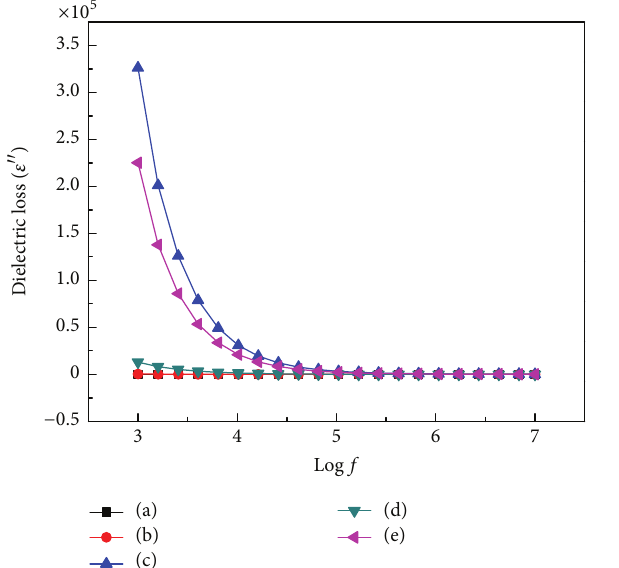
Figure 8: Electric modulus of real part versus frequency for various Ppy/TiO 2 composites (a) 1wt% Ppy/TiO 2 , (b) 2 wt% Ppy/TiO 2 , (c) 3 wt% Ppy/TiO 2 , (d) 4 wt% Ppy/TiO 2 , and (e) 5wt% Ppy/TiO 2 composites. ×10 −3